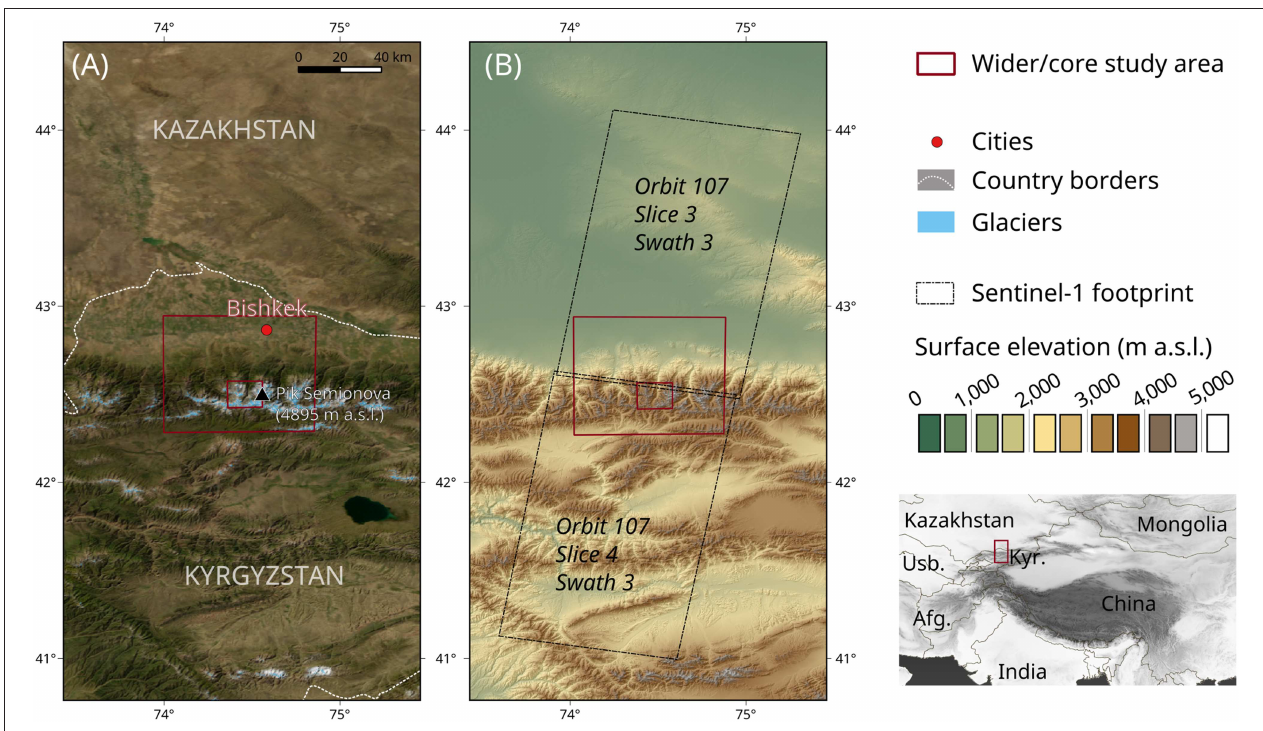
FIGURE 1 | Overview of the case study region in the north-western Tien Shan mountain range. (A) Satellite image showing the distribution of vegetation, glaciers and the location of the city of Bishkek in the northern part of the study area. Satellite image from NASA Blue Marble, Glaciers from Randolph Glacier Inventory v6 (RGI Consortium, 2017). (B) SRTM-based topography and location of the Sentinel-1 scenes/swathes used in the study. The outer red box indicates the locations of the larger study area including the mountain front, alluvial fans, plains and the city of Bishkek; the inner box refers to the glacierized high-mountain core study area in the Ala Archa range (cf. Figure 2